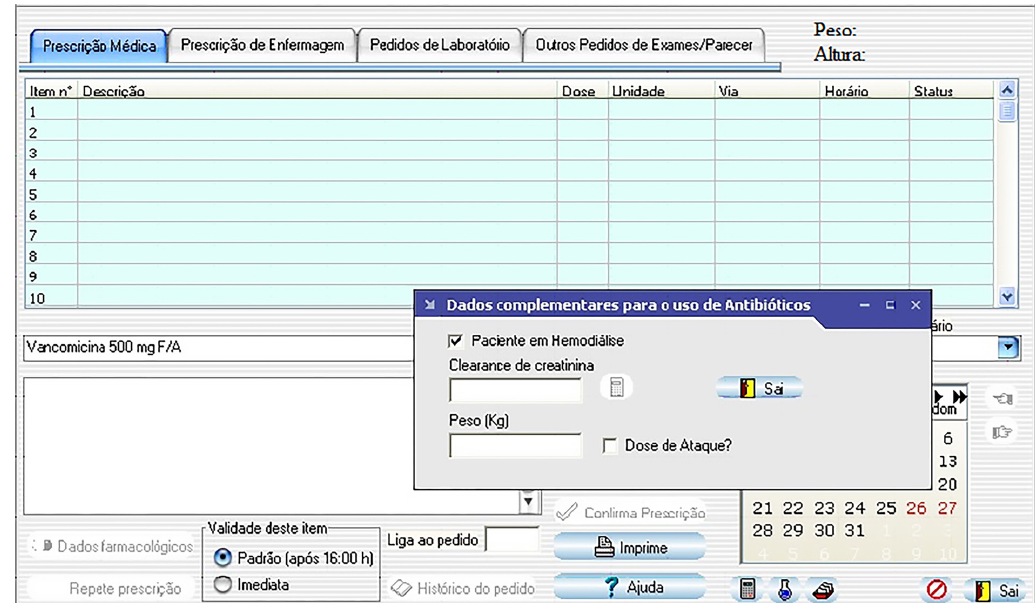
FIGURE 1 - Vancomycin e-prescribing chart sheet and window with requested patient parameters. Subtitle: Peso is Weight, Altura is Height. Dados complementares para o uso de antibióticos is Additional data for antibiotic dosing, Paciente em hemodiálise is Patient on hemodialysis, Clearance de creatinina is Estimated creatinine clearance, Dose de ataque? is loading